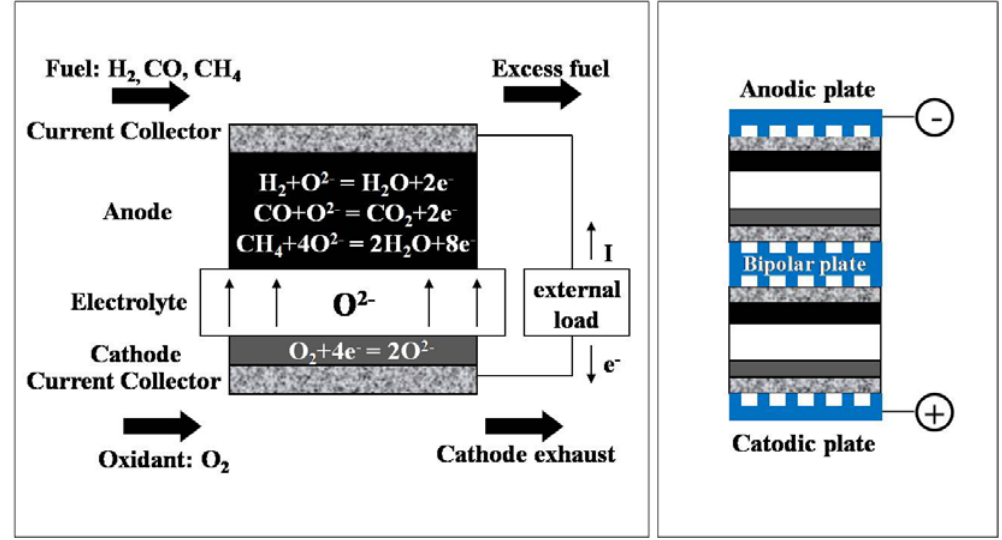
Figure 3. Scheme and performance of a SOFC and SOFC stack operating with different fuel